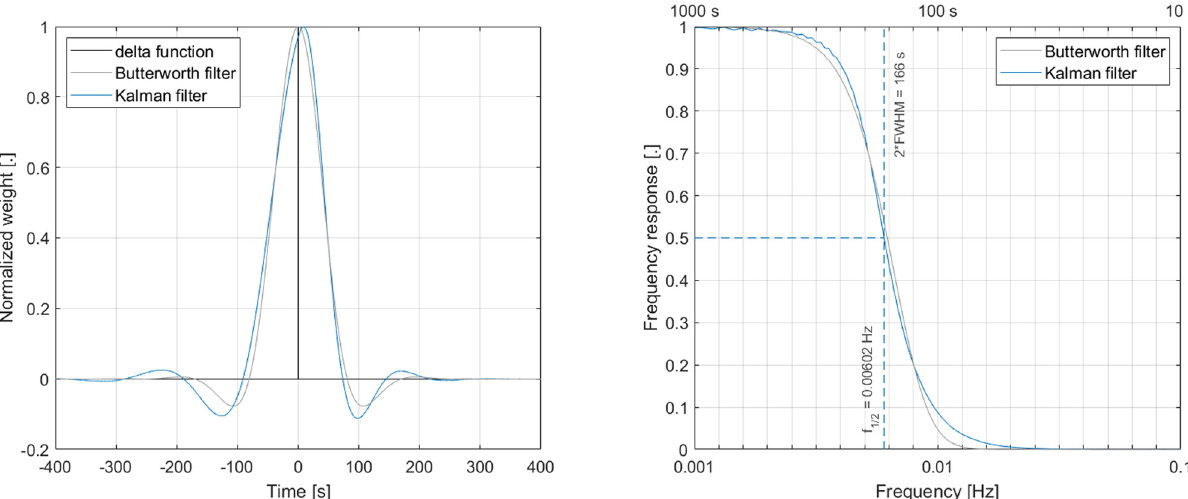
Figure 3: Illustration of the normalized weight function and transfer function derived from the di ff erences shown in Figure 2. Also shown are the curves derived from a third - stage, second - order Butterworth fi lter with a time constant of 115 s. ( Left ) Normalized convolution fi lter. ( Right ) Transfer function.